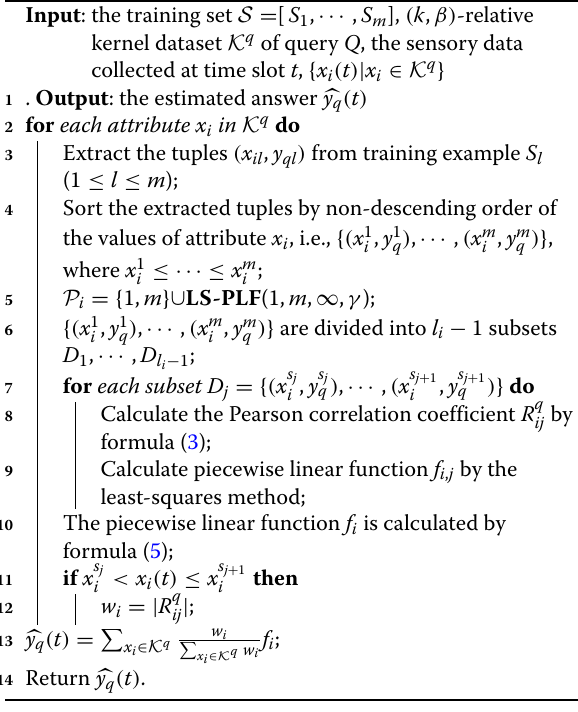
Algorithm 4: Piecewise Linear Fitting Based Answer Estimating Algorithm